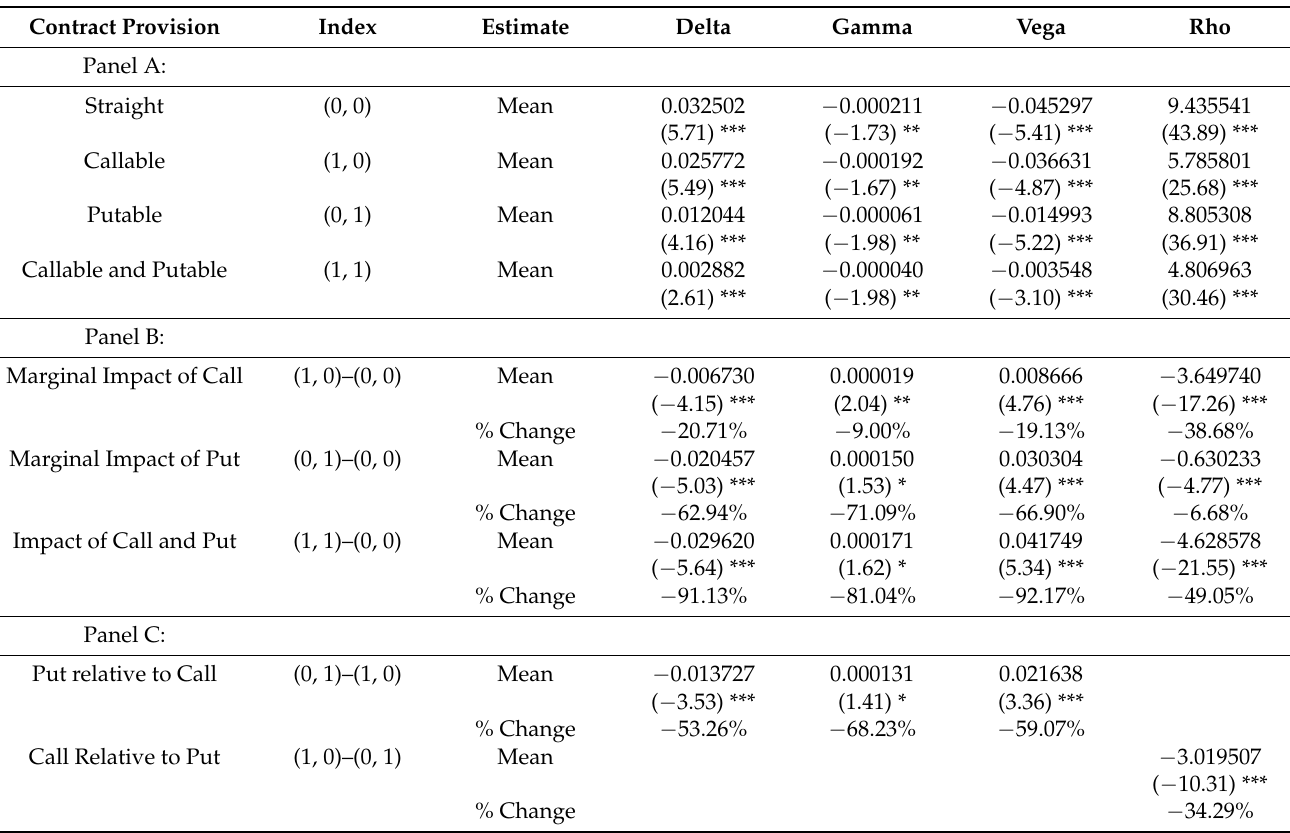
Table 3. Greeks ( Delta , Gamma , Vega , and Rho ) evaluated at the Lower Bound of the firm’s